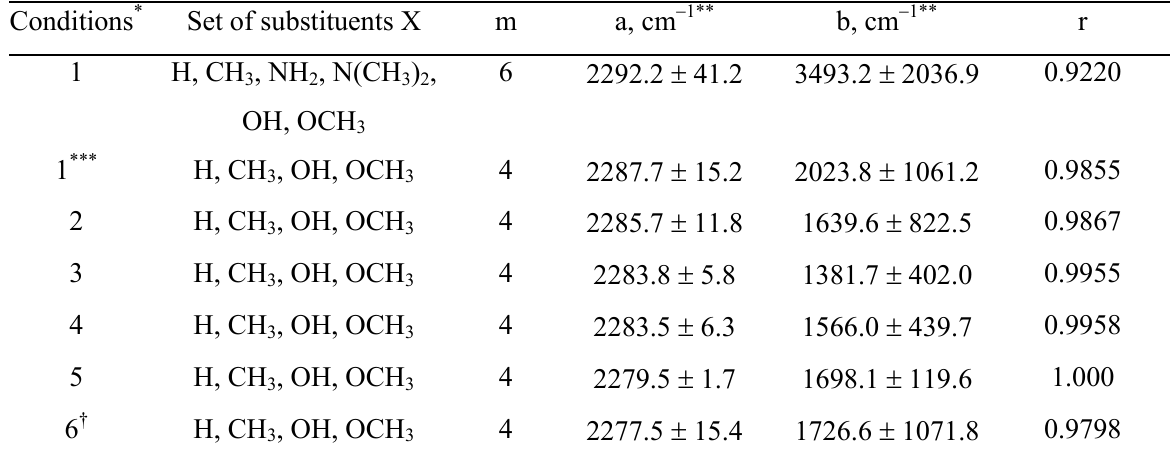
Table 4a. Correlations of stretching vibrational frequencies ( ν ) for fragment C-N + ≡ N bonds